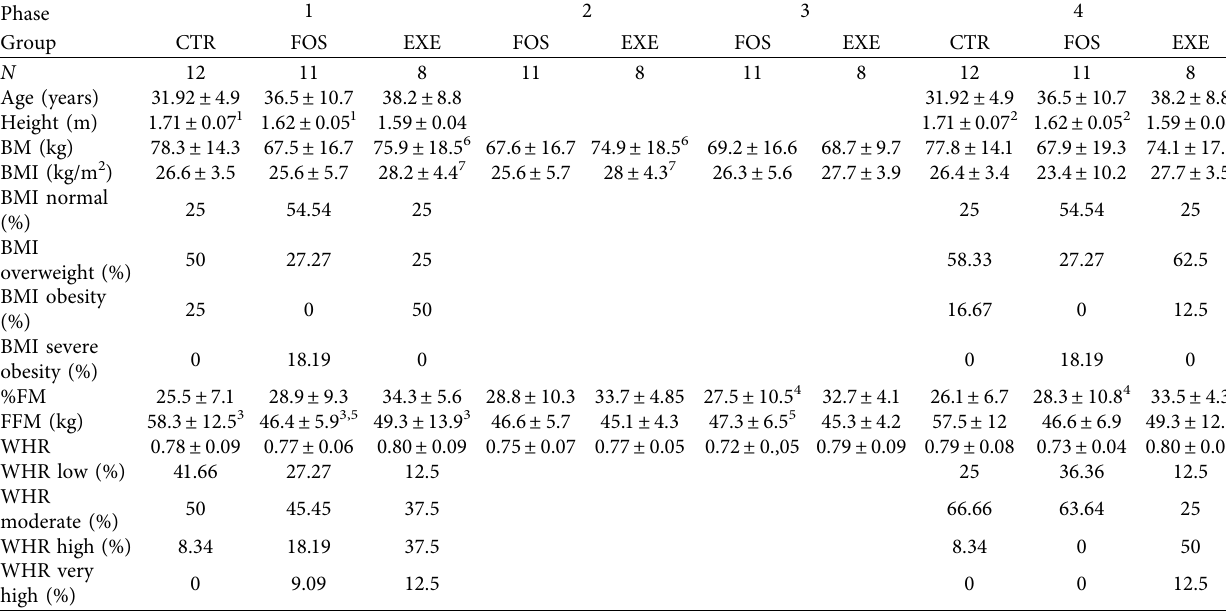
Table 1: Age and anthropometric parameters in celiac disease patients and healthy people—intergroup analysis.